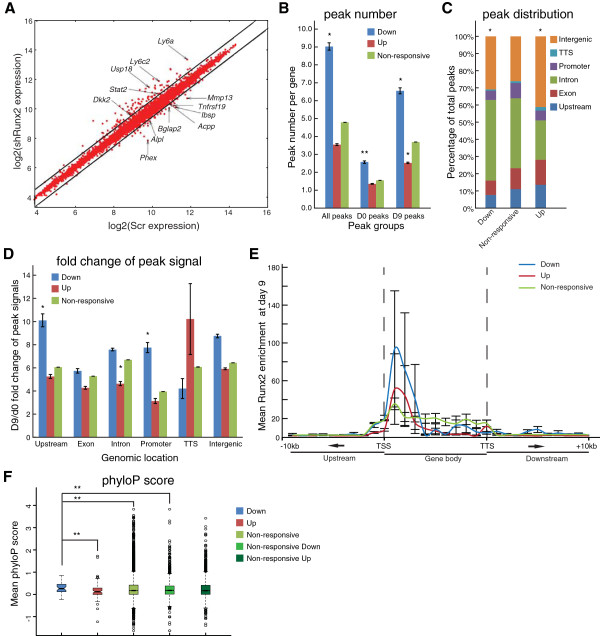
Correlation of Runx2 occupancy and Runx2-reponsive genes identifies novel targets. (A) Expression levels of genes responsive to Runx2 silencing in differentiated MC3T3-E1 cells. Values are plotted as the log2(expression level) from shRunx2-expressing cells (vertical axis) versus control shRNA expression (horizontal axis). Each point represents mean mRNA expression level from three independent biological replicates. Several representative genes are labeled. Diagonal lines demarcate the threshold for significant increase or decrease (≥1.5-fold) in expression. (B-D) Runx2 peaks associated with upregulated (Up), downregulated (Down), or unchanged (Non-responsive) gene expression upon Runx2 knockdown were compared by: average peak number per gene (B), and peak distribution (C) and fold change of peak signals (d9 versus d0) across genomic locations (D) with shRunx2 non-responsive genes as a control. In (B), three groups were compared to non-responsive genes: all peaks in shRunx2-regulated genes (All peaks), all peaks present at day 9 in shRunx2-regulated genes (D9 peaks), and all peaks present at day 0 in shRunx2 regulated genes (D0 peaks). Values are mean ± SEM (B,D) and statistical significance (*P < 0.01, **P < 0.05) determined by Mann-Whitney test (B,D) or Fisher’s exact test (C). (E) Runx2 enrichment across gene bodies (±10 kb) of genes downregulated (Down), upregulated (Up), and unchanged (Non-responsive) by shRunx2 treatment at day 9. Mean signal ratios (IP/Input) at each genomic region were determined using PeaksToGenes. Error bars represent SEM. (F) Mean phyloP conservation scores of Runx2 motifs associated with genes significantly (fold change ≥1.5, FDR <0.05) downregulated (Down), upregulated (Up), or unchanged (Non-responsive) upon shRunx2-treatment. Conservation of Runx2 motifs was compared between shRunx2 downregulated and upregulated genes and length-matched non-responsive genes (Non-responsive, Down and Up, respectively) and statistical significance determined (**P < 0.05) by Kolmogorov-Smirnov test.